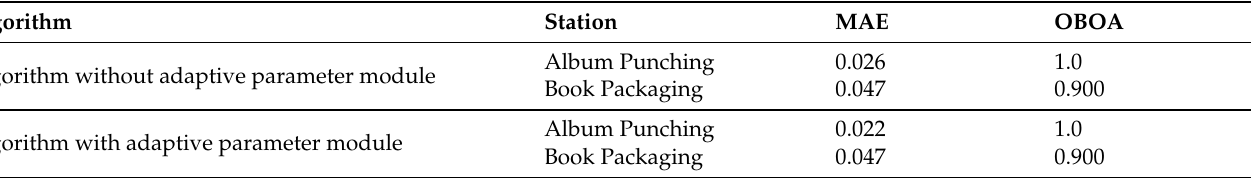
Table 3. Comparison of the performance between the algorithm with adaptive parameter and the algorithm without adaptive